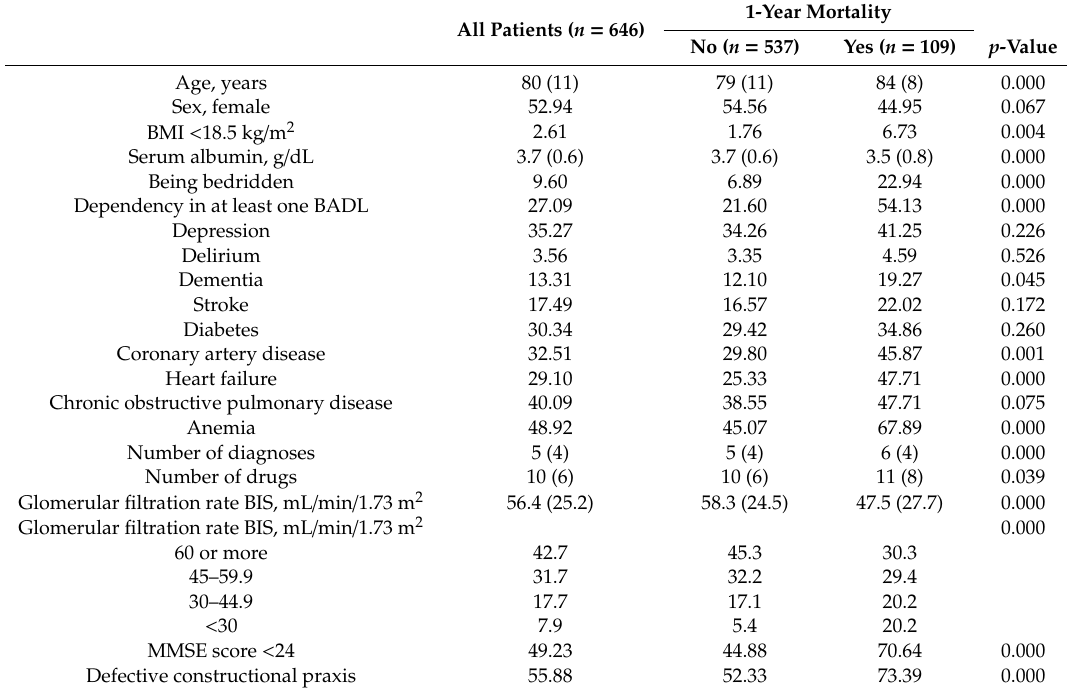
Table 1. General characteristics of patients according to 1-year